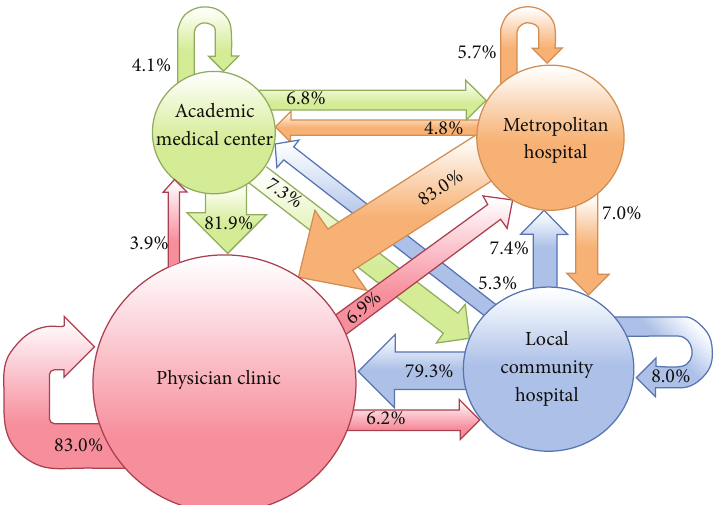
Figure 2: Flow of patients with visits to different accreditation level of healthcare facilities within one day in the 1,000,000-person cohort in 2010.